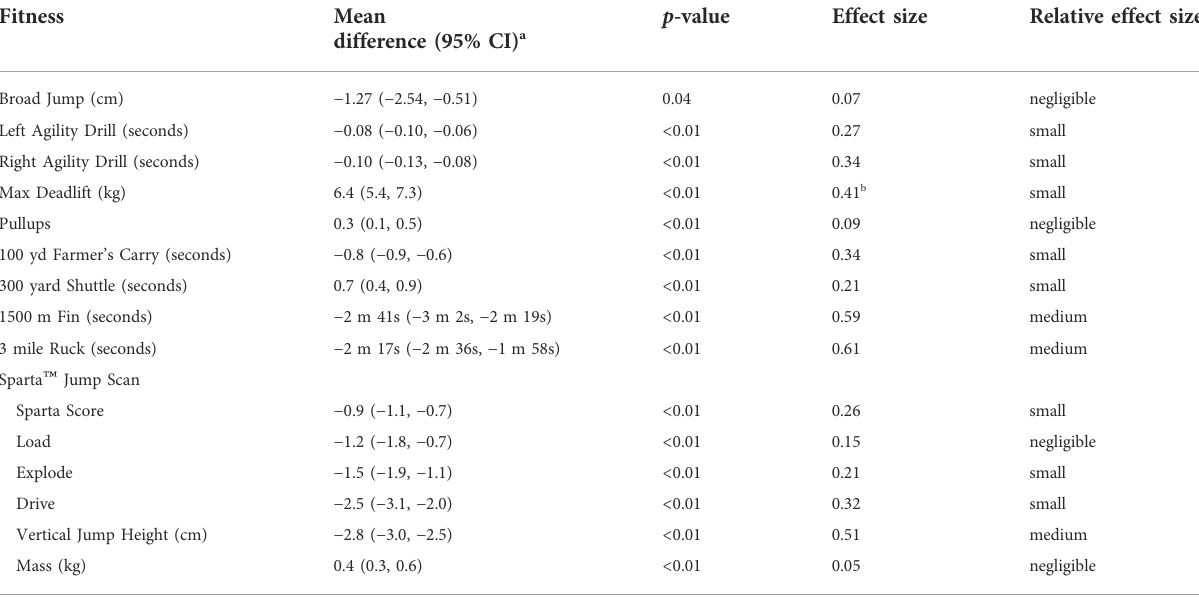
TABLE 2 Hypothesis testing results for comparisons of initial vs. fi nal means of SpartaTM Jump Scan metrics and Candidate Fitness Test measurements. For all comparisons, except Max Deadlift, a paired t -test was used to test mean differences, and Cohen ’ s D was calculated to measure effect size. For Max Deadlift, mean differences were tested using a Wilcoxon Signed-Ranks test, and effect size was calculated according to recommendations by Rosenthal and Rubin (1991). Fitness Mean difference (95% CI)